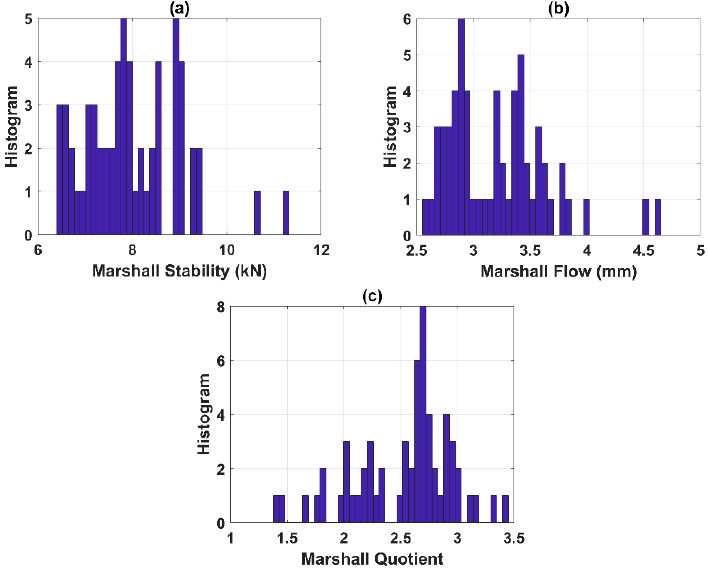
Figure 4. Histogram of the output parameters considered in this study for: ( a ) Marshall Stability (MS); ( b ) Marshall Flow (MF) and ( c ) Marshall Quotient (MQ).